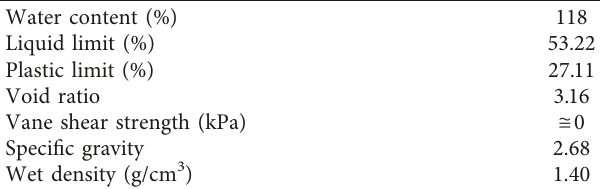
Table 1: Summary of the subsoil